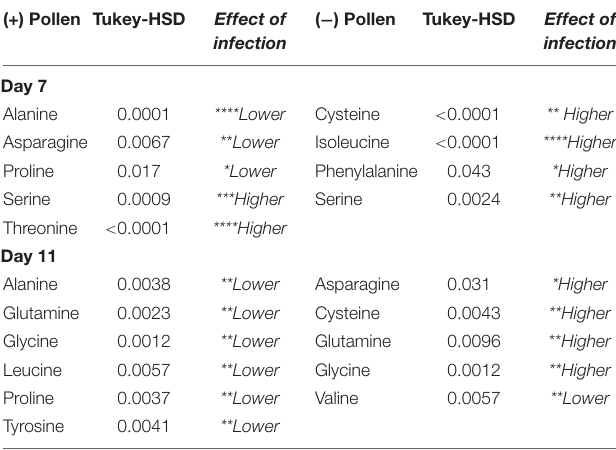
TABLE 3 | Amino acids affected by Nosema ceranae infection by age and pollen in the honey bee brain. (+) Pollen